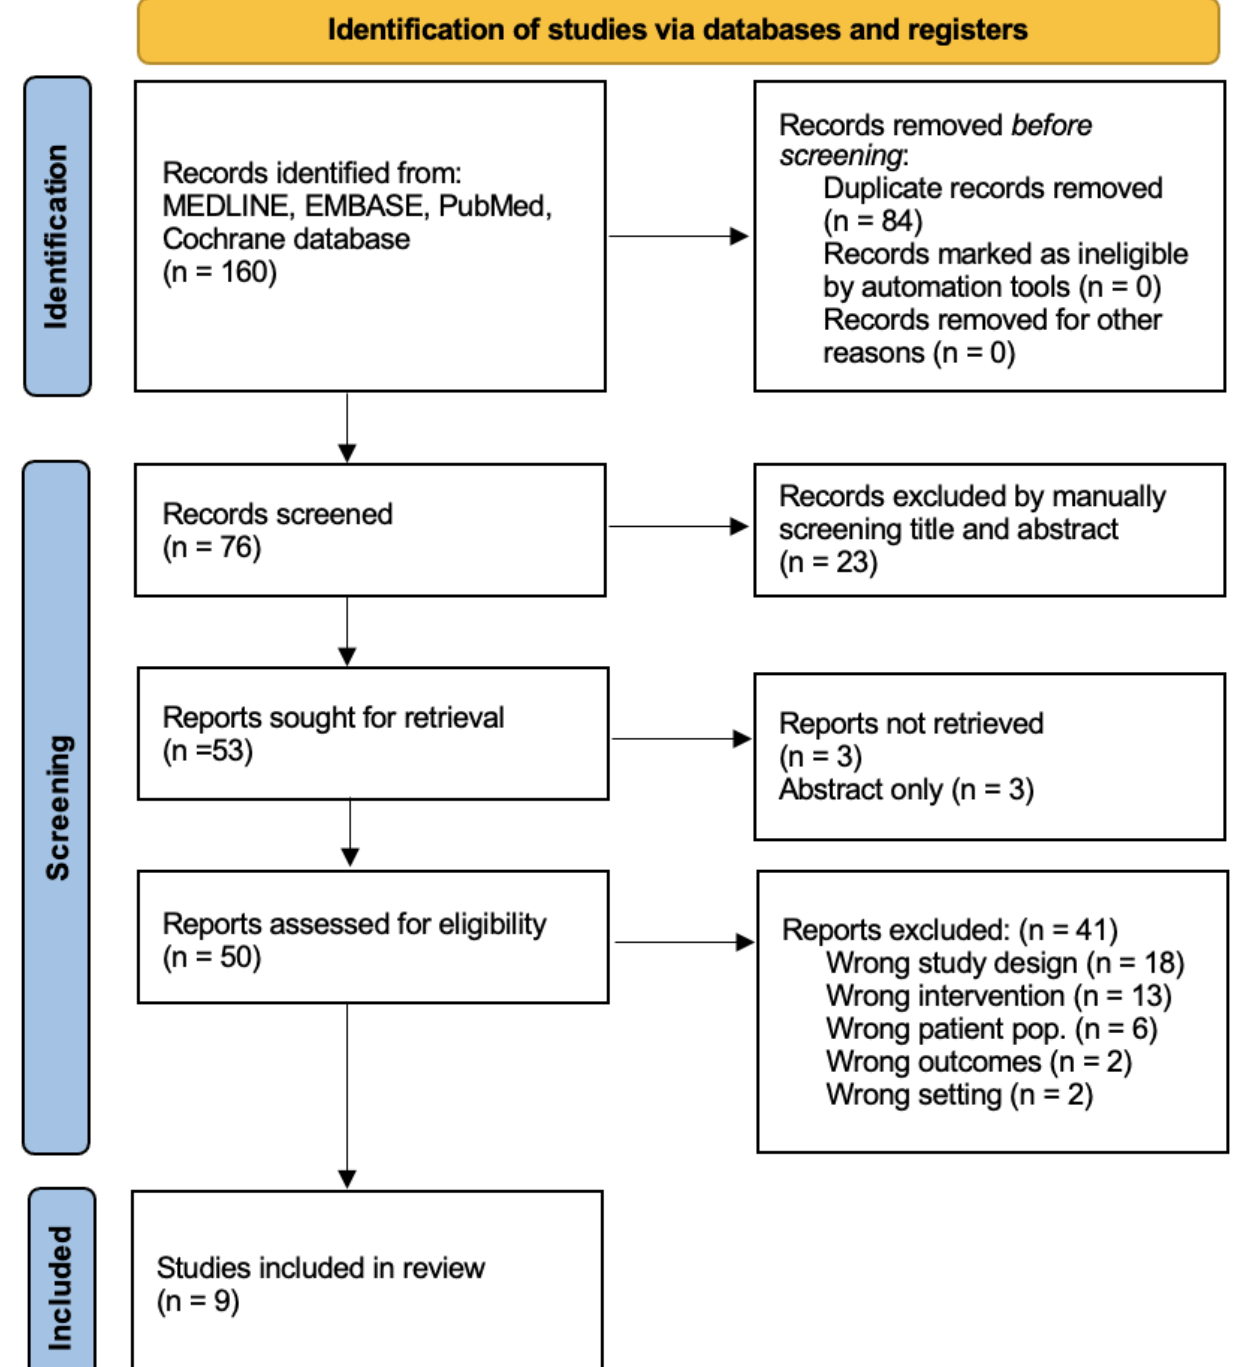
Figure 1. PRISMA table outlining results of literature search.